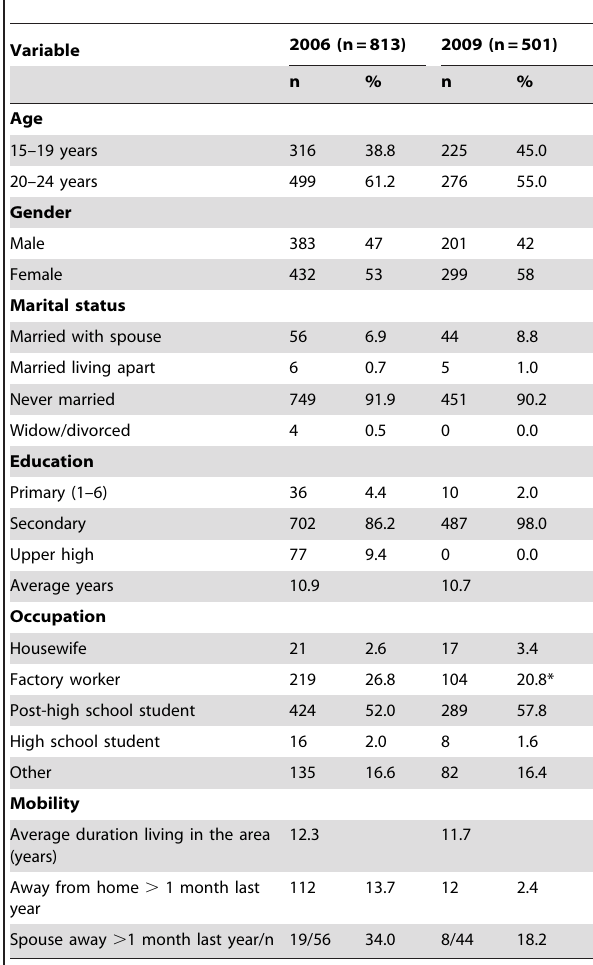
Table 1. Demographic characteristics of community and factory